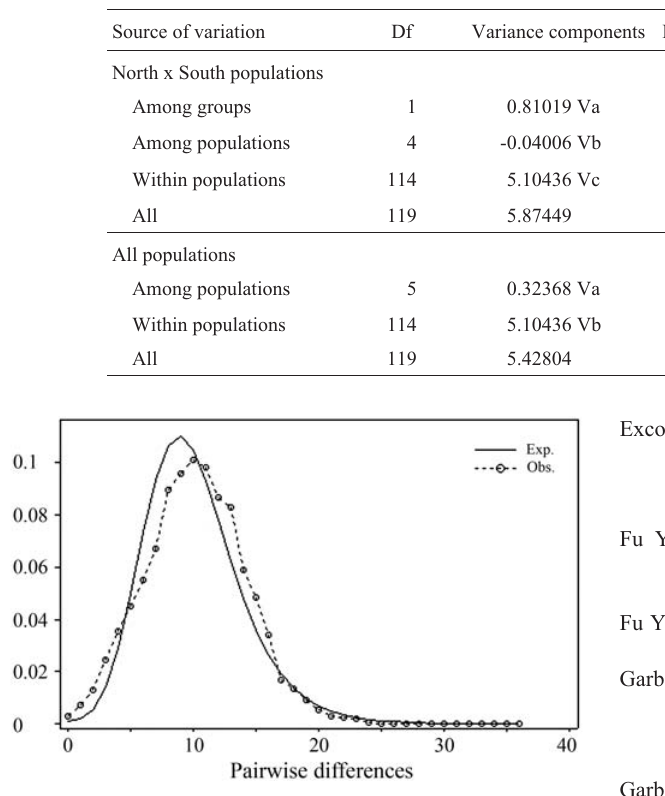
Figure 2 - Mismatch distribution based on 120 D-loop sequences of L. purpureus and L. campechanus from six localities of the West Atlantic. The solid line is the observed and the dotted line is the expected distribu- tion of the pairwise differences.